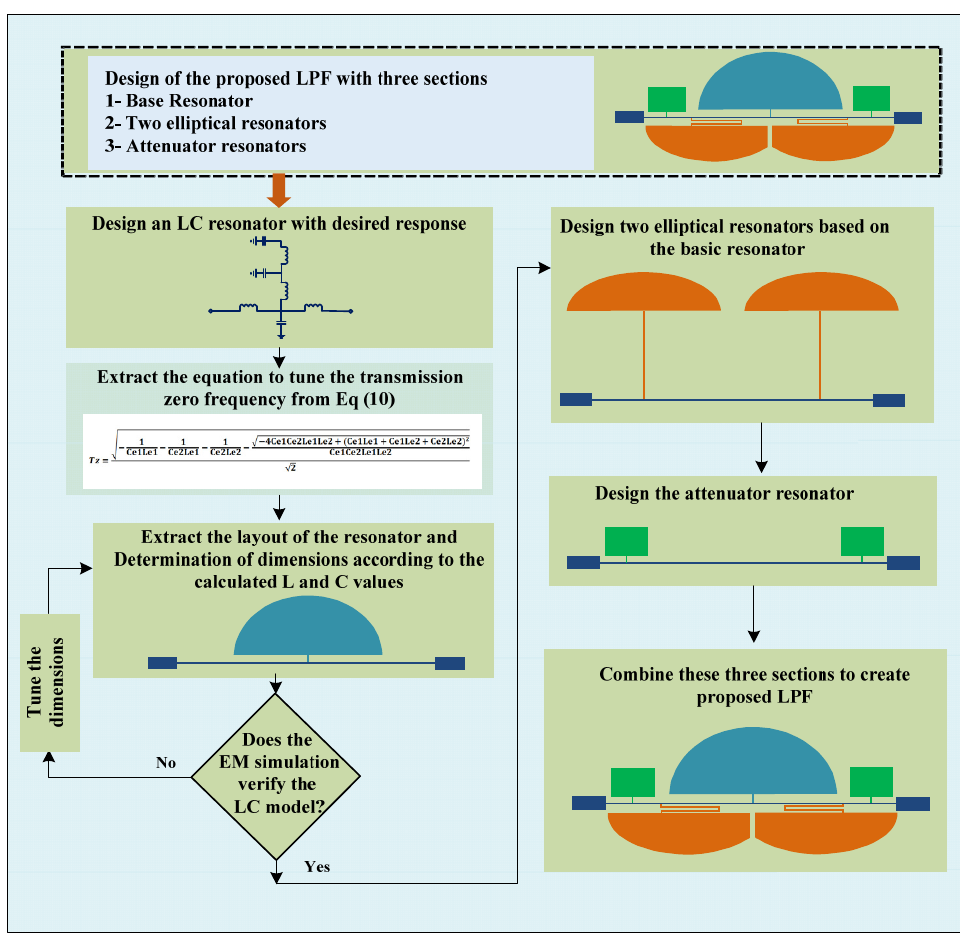
Figure 1. The design process of the proposed low pass filter.